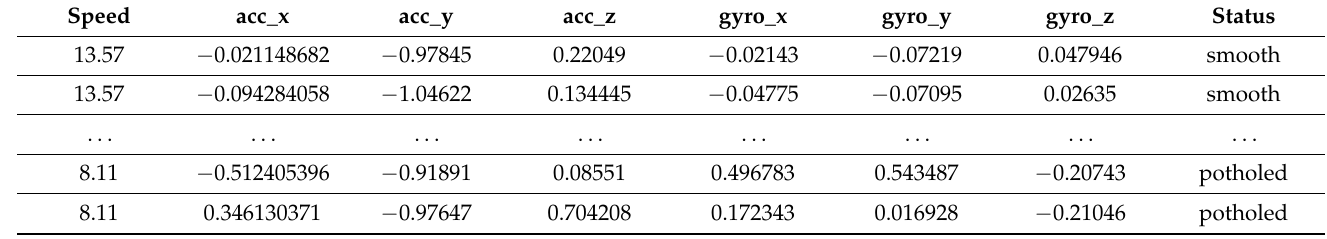
Table 2. A sample of the data used in the experiments.